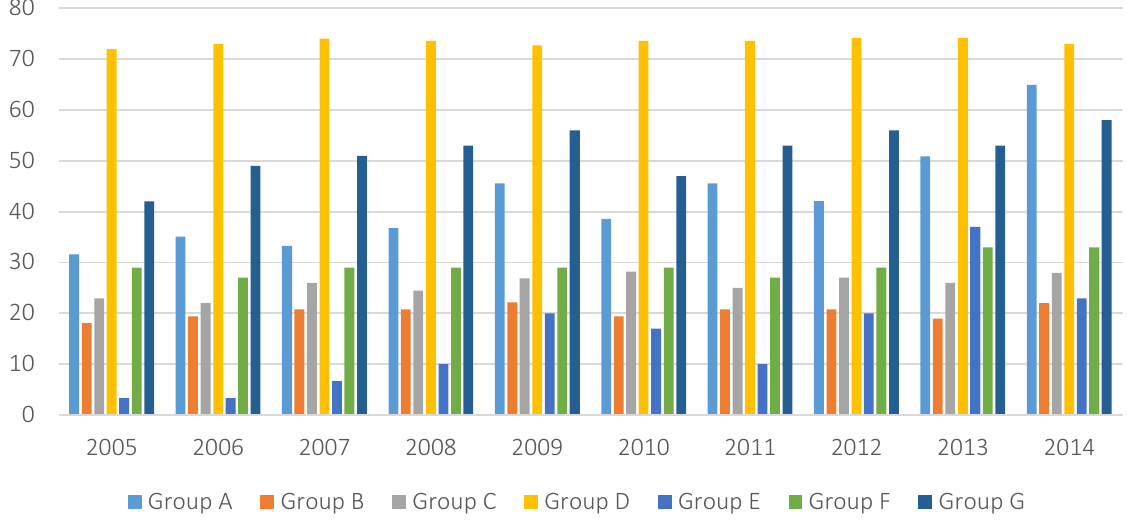
Figure 1. The degree of voluntary disclosure